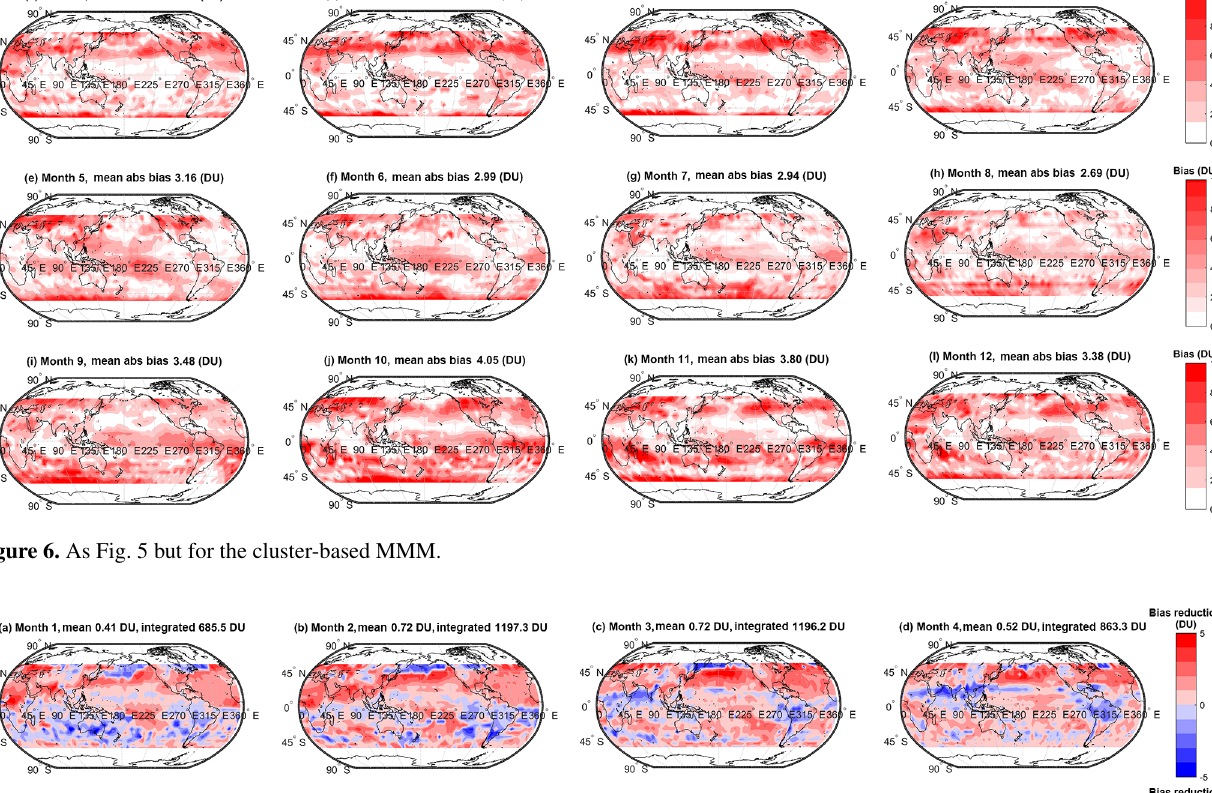
Figure 6. As Fig. 5 but for the cluster-based MMM.